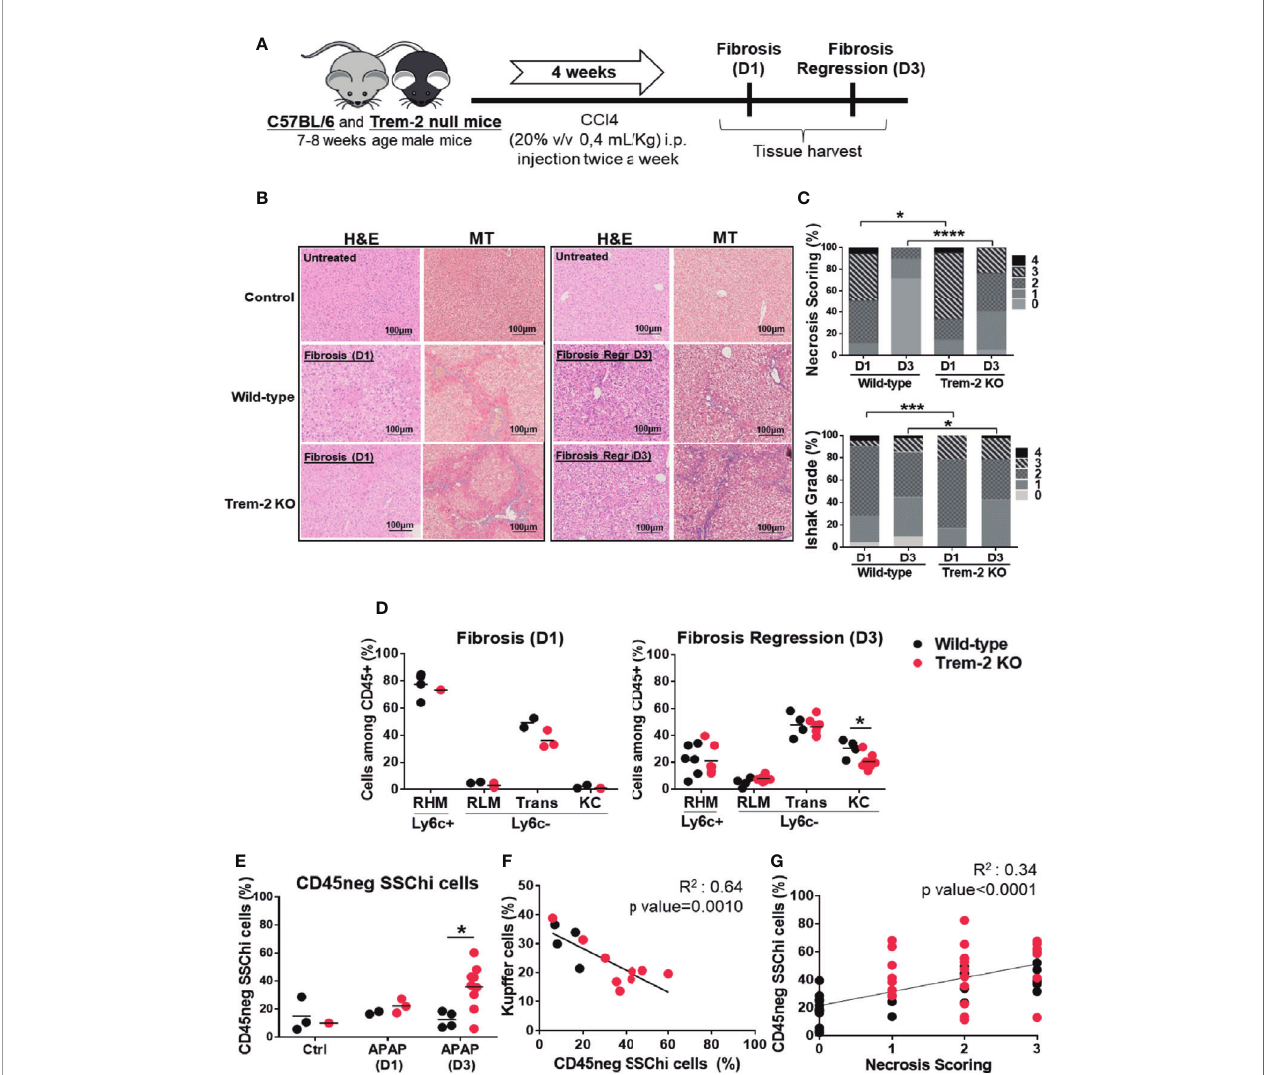
FIGURE 3 | Responses to chronic liver injury are impaired in Trem-2 KO mice. Chronic liver injury was induced by administration of CCl4 during 4 weeks, twice a week. Mice were analyzed one or three days after the last injection, corresponding to fi brosis-D1 and fi brosis regression-D3 time points in wild-type mice (A) . Liver necrosis was evaluated using hematoxylin-eosin (H&E) staining (B) and scored from 0 to 4 according to location and extension of the necrotic lesions (C) . Masson ’ s trichrome (MT) staining was used to identify and quantify collagen fi bers (blue) (B) using an adapted Ishak grading (D) . Applying the fl ow cytometry criteria depicted in Figure 2 we quanti fi ed cell frequencies of distinct macrophage populations: recruited hepatic macrophages (RHM); Kupffer cells (KC); transition macrophages (Trans); recruited-like macrophages (RLM) (E) and of non-hematopoietic CD45neg SSChi population (F) in wild-type and Trem-2 KO mice for control, fi brosis-D1 and fi brosis regression-D3 time points. Inverse correlation of KC frequency with CD45neg SSChi population at Fibrosis Regression-D3 (G) . Correlation of CD45neg SSChi cells frequency with necrosis scoring at fi brosis regression-D3 time point (H) . Symbols represent values from individual mice. Group mean values are presented. Statistics: For necrosis and Ishak grade scorings, groups were compared using Chi-square test (n=18-48 mice/group) (C) . Two-way ANOVA in (E) and (F) Pearson ’ s correlation test in (G , H) *, p<0.05 ***, p<0.001, ****,